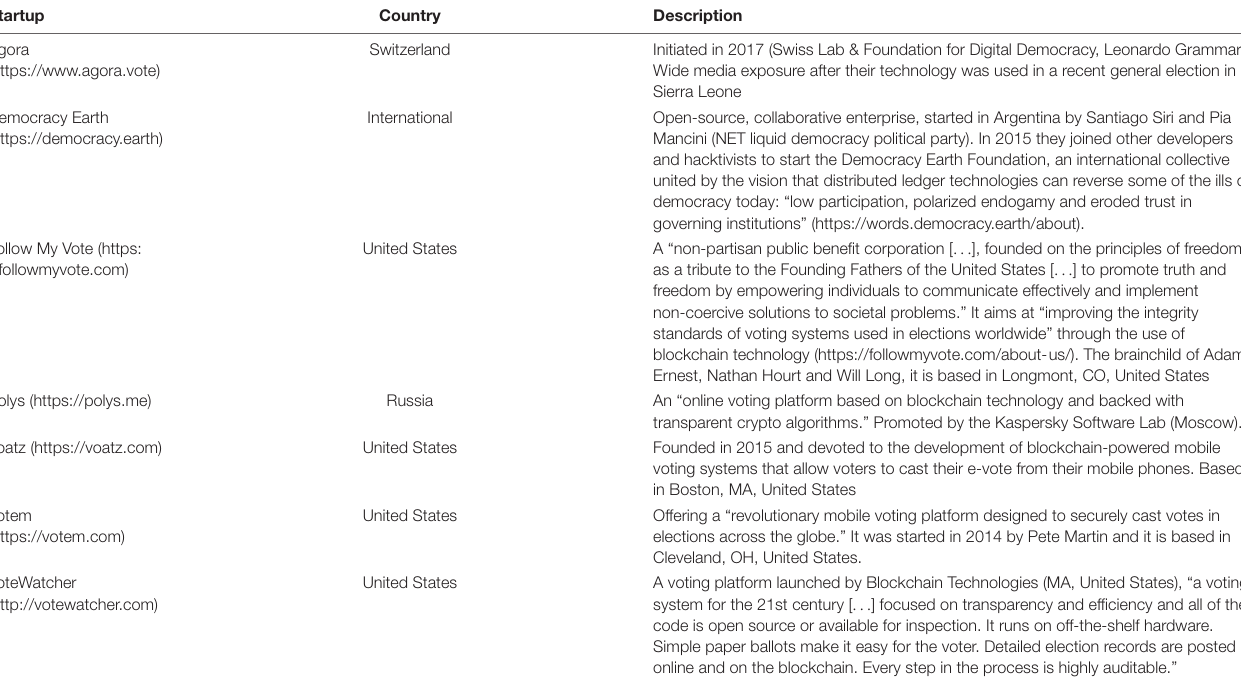
TABLE 1 | Blockchain-powered e-voting startups chosen for study.